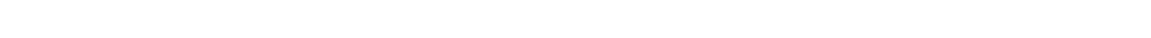
TABLE 1 | Locations and depths of wells in